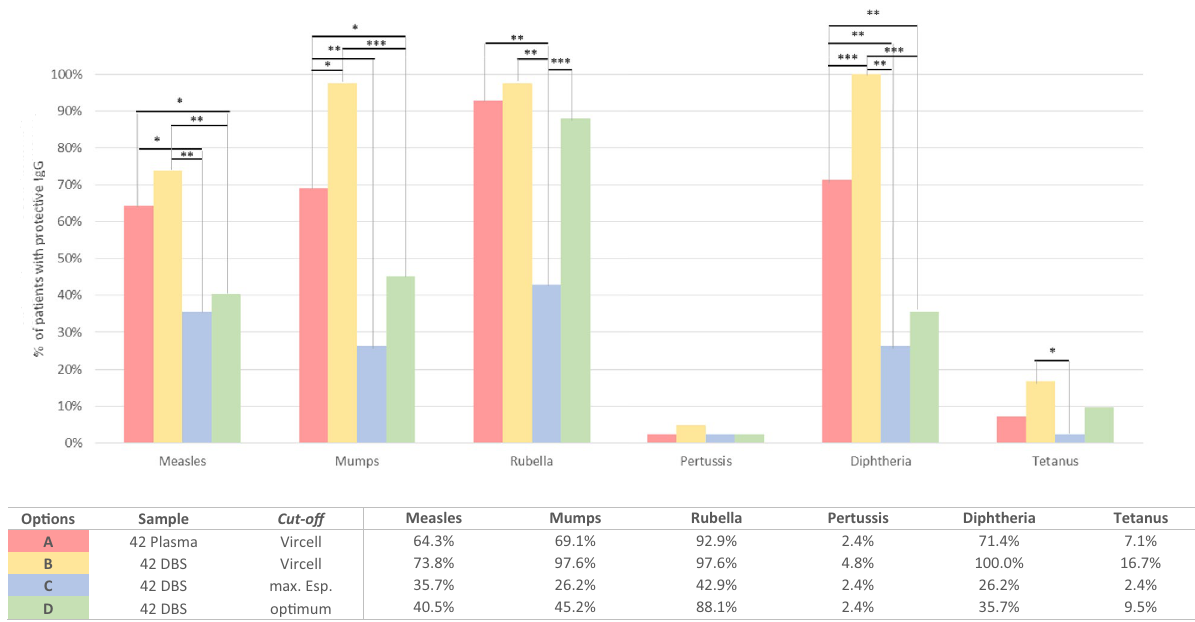
Figure 2. Pathogen immunity in 42 children and adolescents from Kinshasa with paired plasma/DBS considering different cut-offs. The plasma cut-off provided by VIRCELL for each pathogen is shown in Table 1. Options A and B, with the VIRCELL cut-off according to Table 1. Options C and D, with the maximum specificity or optimum cut-offs calculated for each pathogen, as indicated in Table 3. Statistically significant differences found: * p = 0.01–0.03; ** p = 0.001–0.003; *** p <